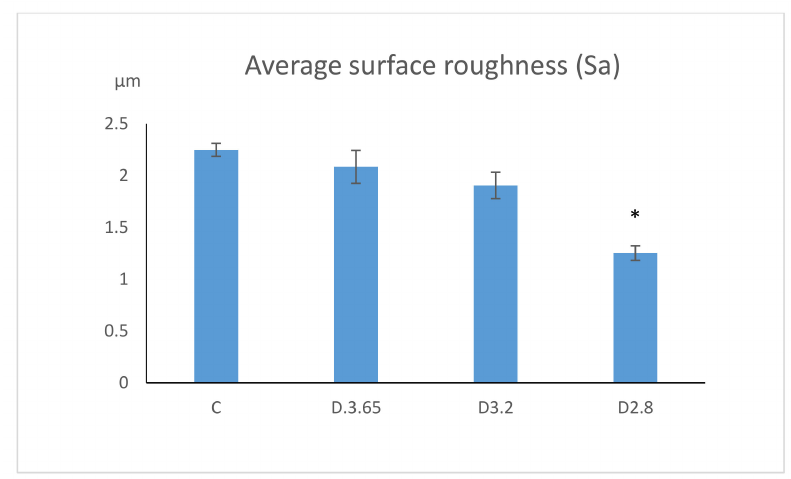
Figure 6. Surface roughness (Sa) values measured in the di ff erent study groups. The results are represented as averages and standard errors. * denotes p <